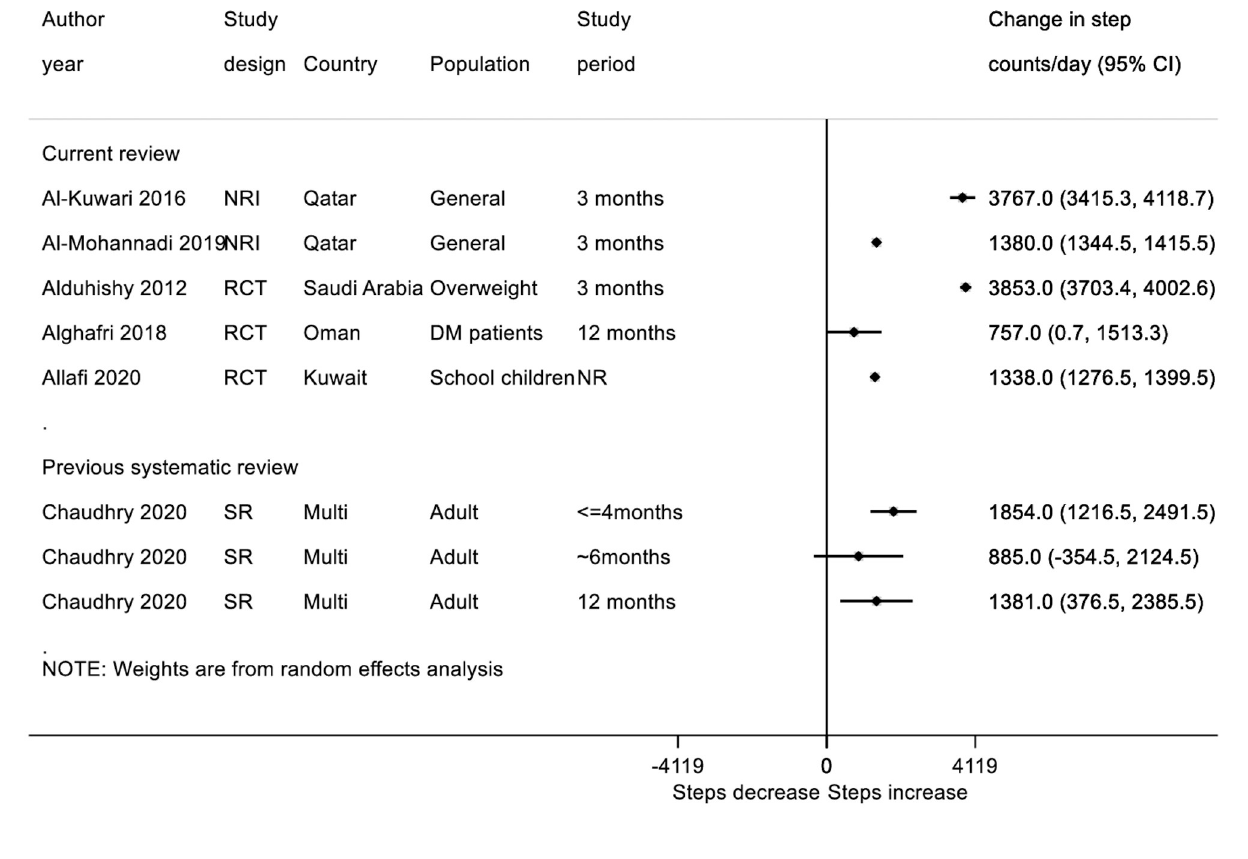
Fig 3. Forest plot of included randomized control studies on PA intervention on step count per day compared to summary estimates from previous systematic review by Chaudhry 2020.